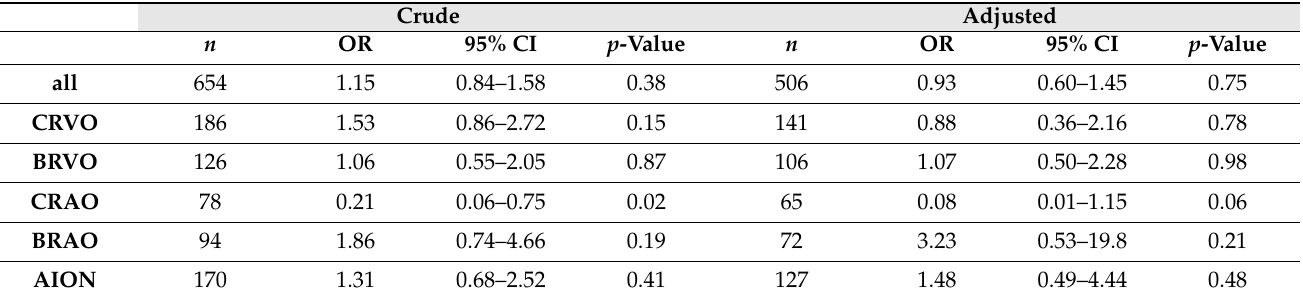
Table 3. Association analysis between the COVID-19 vaccination status in subjects with retinal vascular occlusion (4 weeks prior to diagnosis) compared to population-based age- and sex-matched controls from the Gutenberg Health Study. A conditional regression analysis was computed in an (I) unadjusted way and (II) adjusted for diabetes, obesity, arterial hypertension, smoking, and the use of